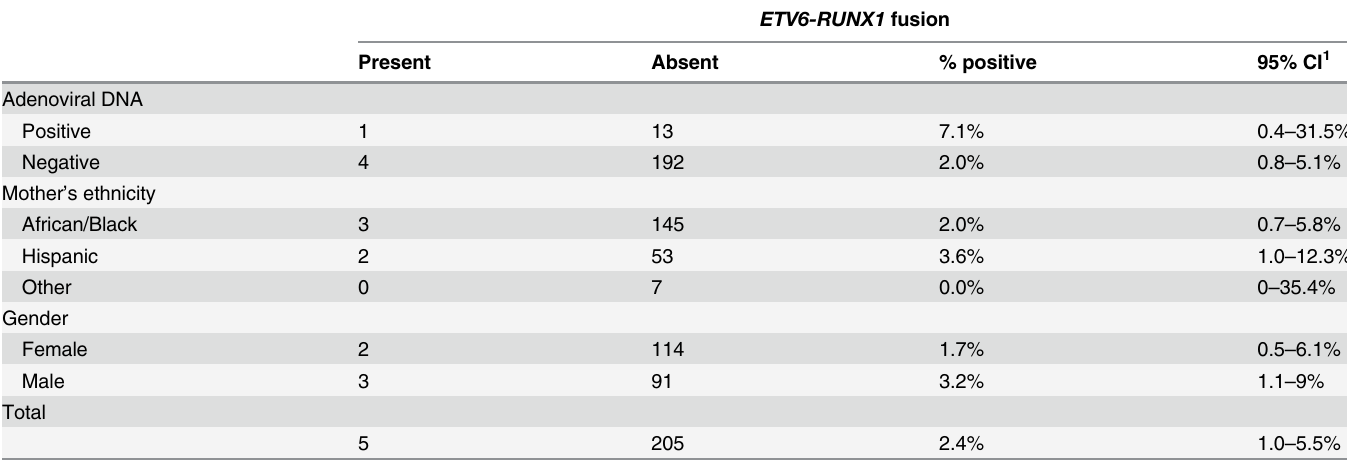
Table 2. Detection of ETV6-RUNX1 fusion transcript in cord blood RNA.